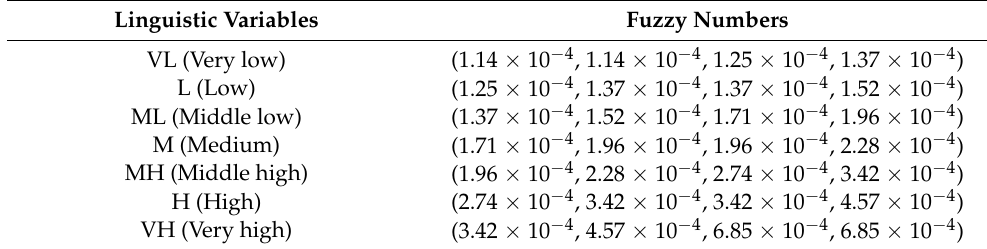
Table 2. Fuzzy numbers corresponding to language variables. Linguistic